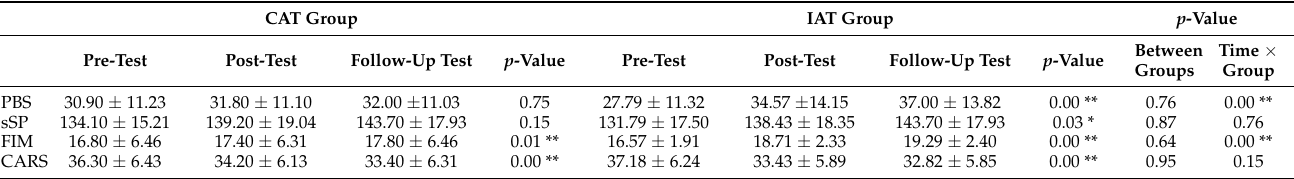
Table 2. The outcome analysis on physical, sensory, and cognitive